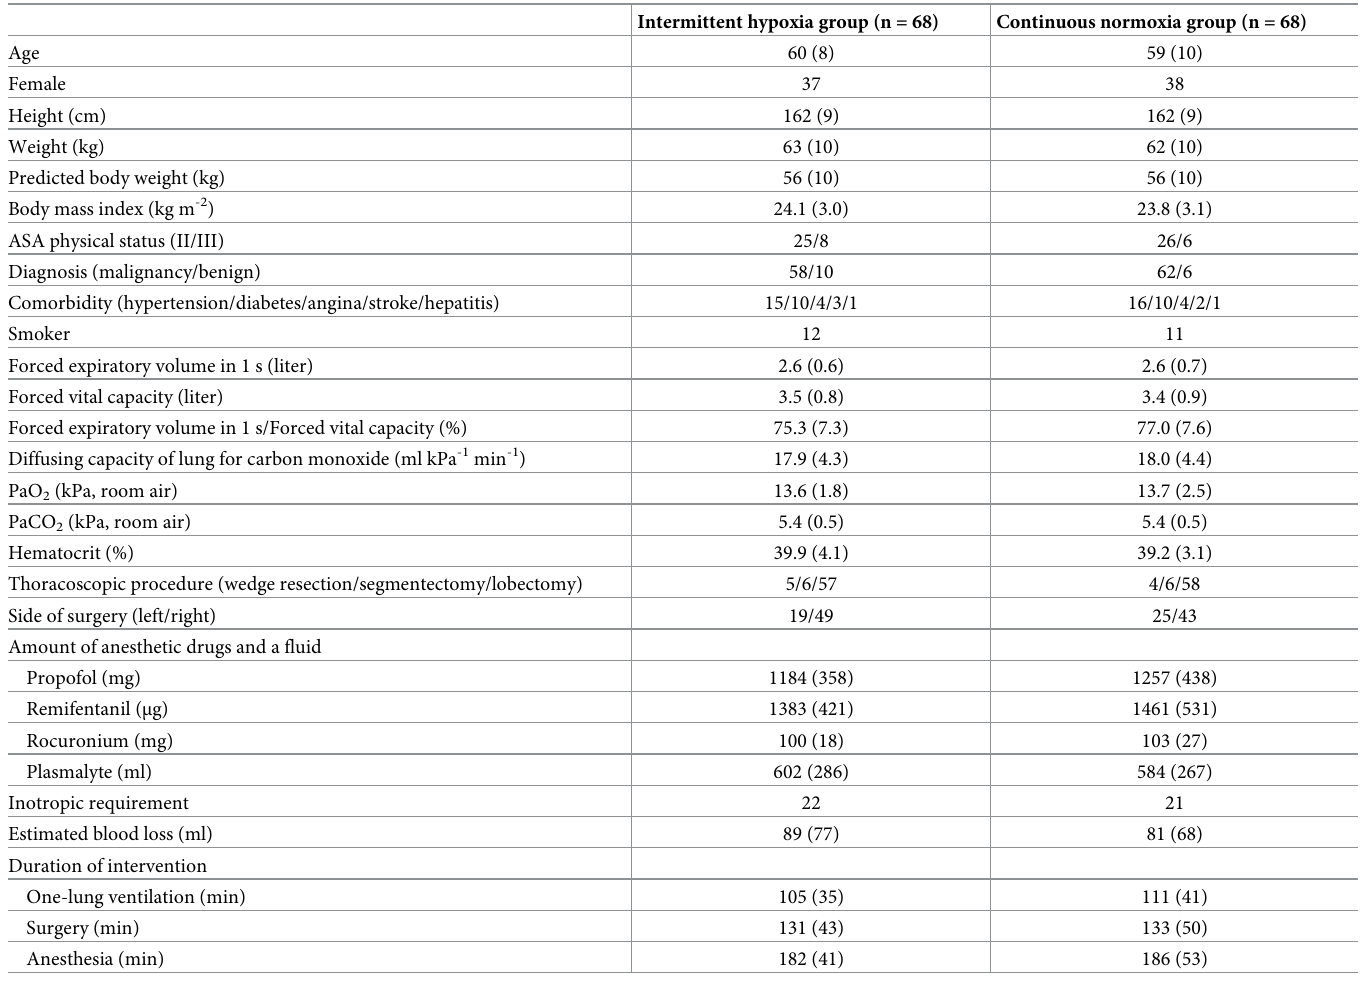
Table 1. Characteristics of patients, surgery, and